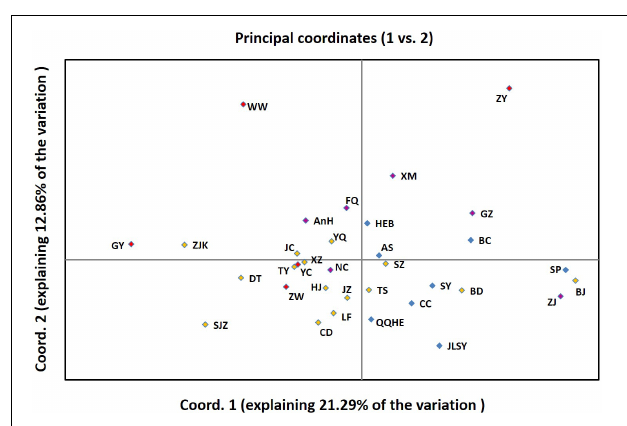
FIGURE 6 | Principal Coordinates Analysis (PCoA) among 34 populations based on Nei’s genetic distance using GenAlEx.